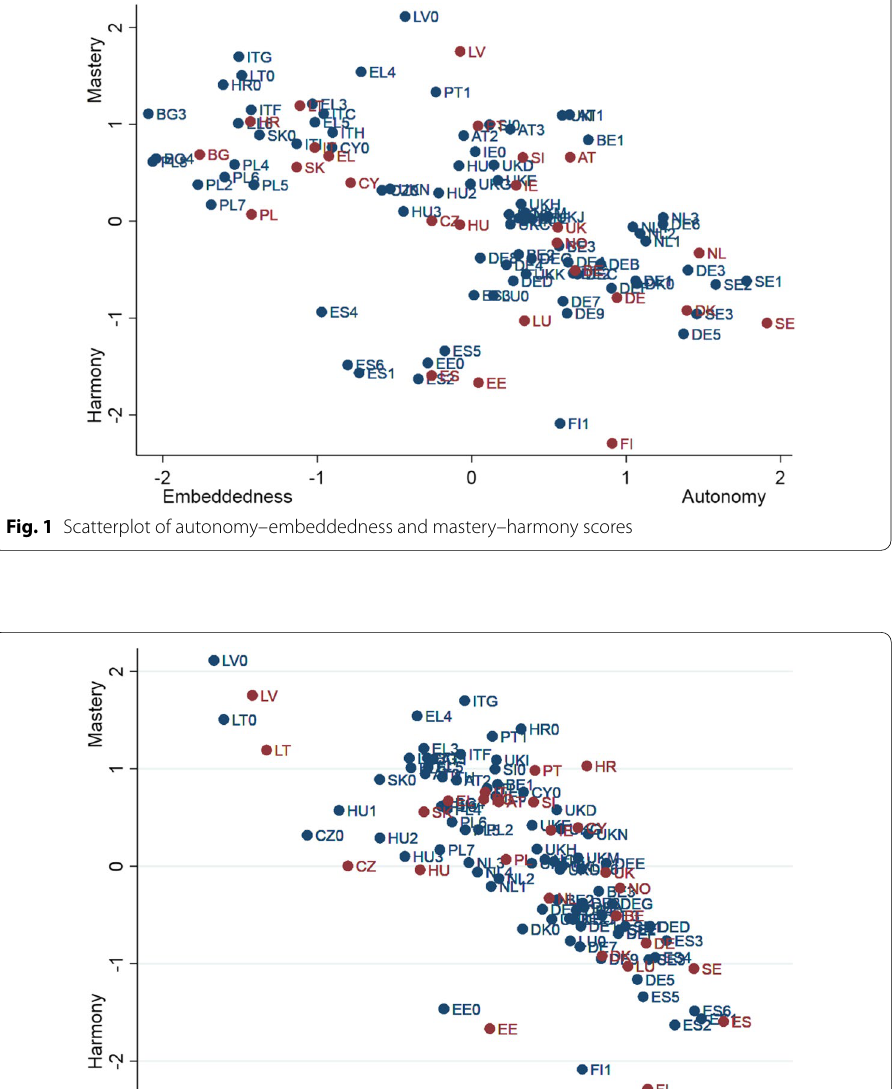
variables at the regional level (blue) and country level (red) with mastery–harmony and autonomy–embeddedness axes (Fig. 1) and mastery–harmony egalitarianism– hierarchy axes (Fig. 2) are shown below.